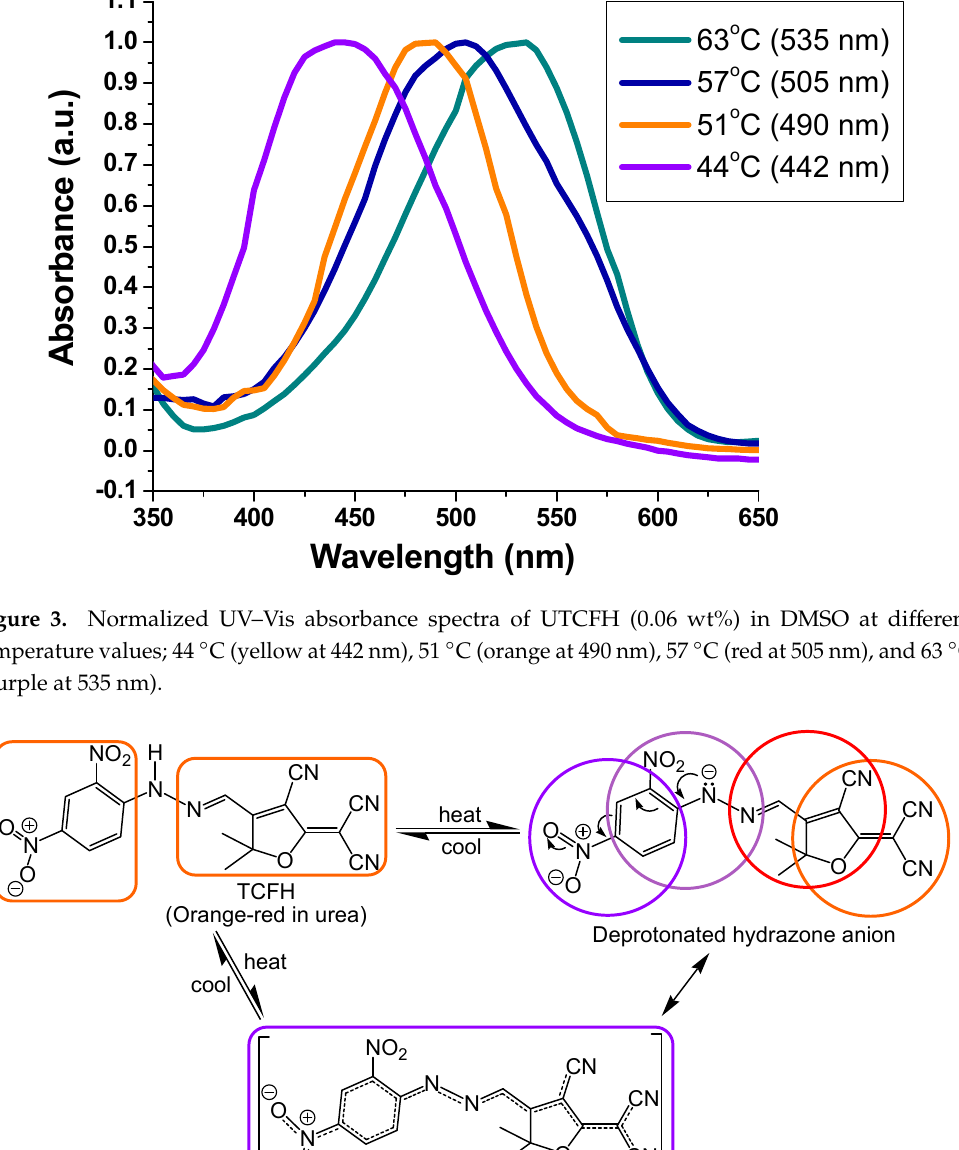
Figure 4. Illustration of thermochromic sol–gel process of UTCFH (0.06 wt%) in DMSO. The purple color of UTCFH was found to reversibly change to yellow upon cooling in dimethyl sulfoxide (DMSO) solution. No similar color shift was monitored with the urea organogel